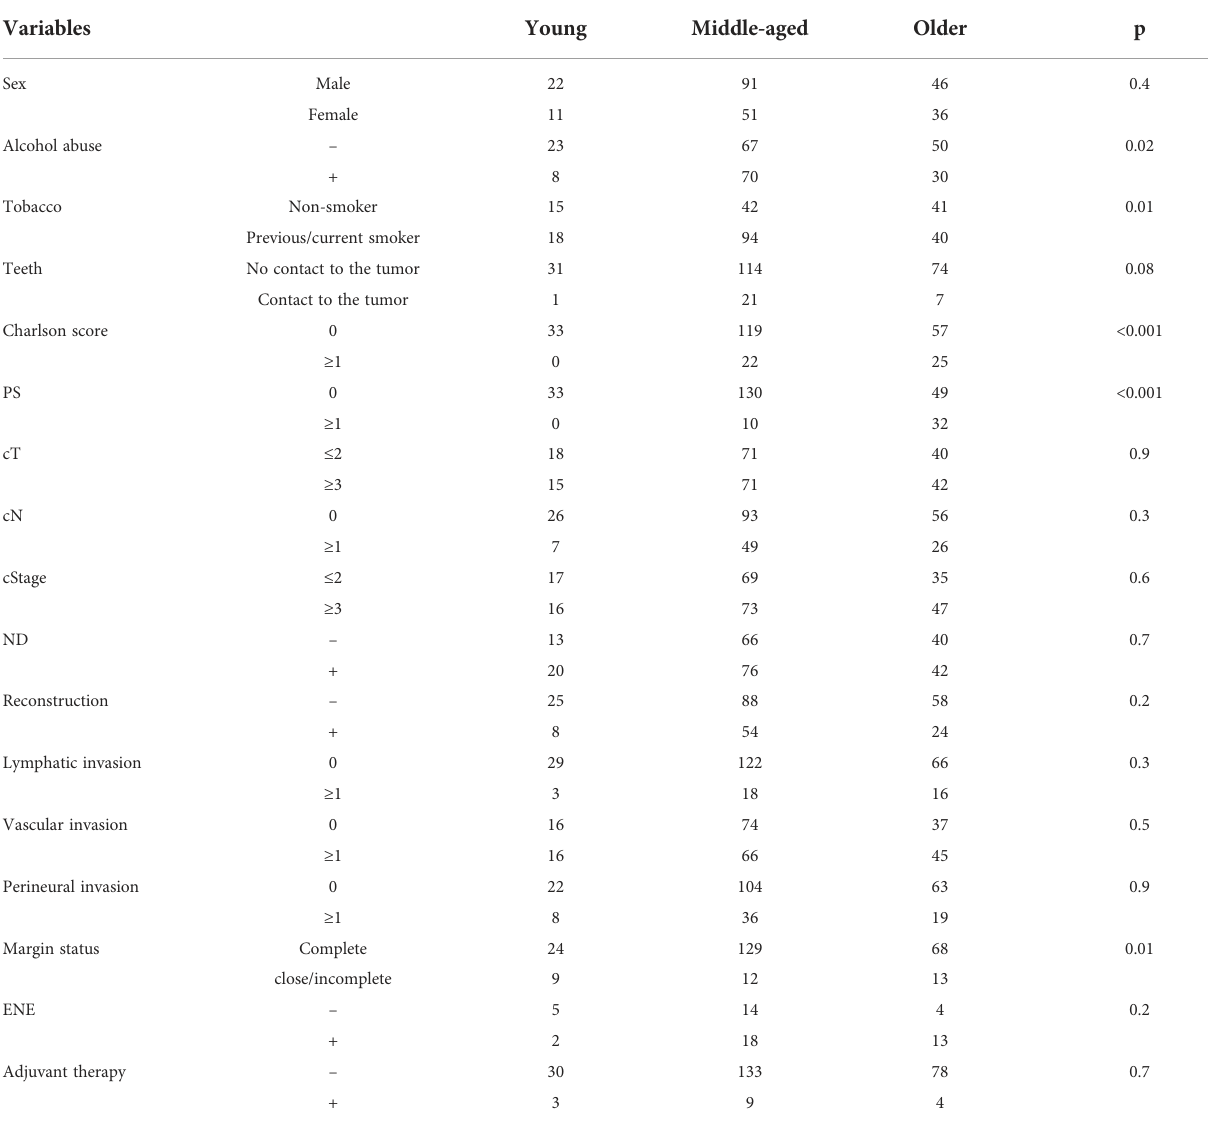
TABLE 1 Patient